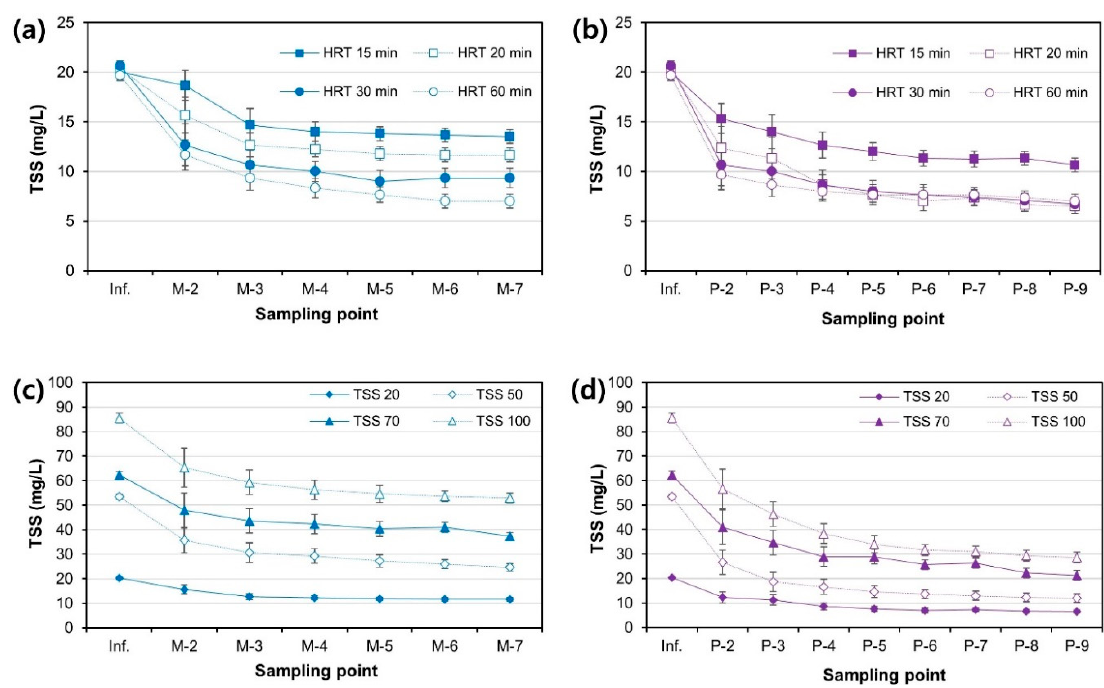
Figure 7. SP concentration at each port of the bench-scale MTF and PFB reactors as a function of influent flow rate and SP concentration: ( a ) total suspended solids (TSS) of MTF (flow rate conditions); ( b ) TSS of PFB (flow rate conditions); ( c ) TSS of MTF (TSS concentration conditions), and ( d ) TSS of PFB (TSS concentration conditions). Each sample was analyzed three times to derive the data reliability and standard deviation.